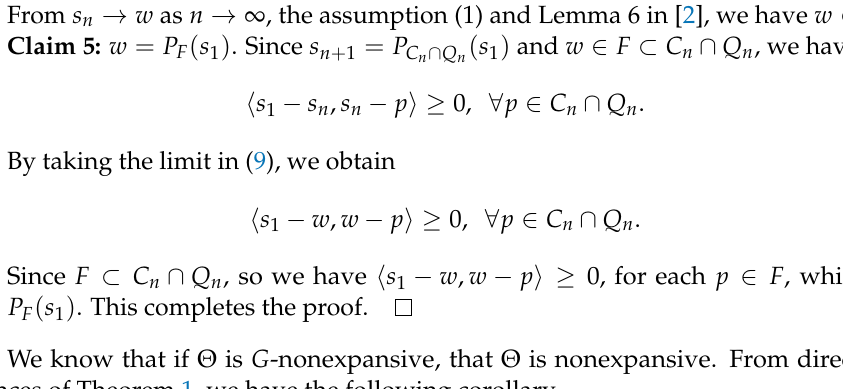
} is a sequence in [ 0, 1 ] for n